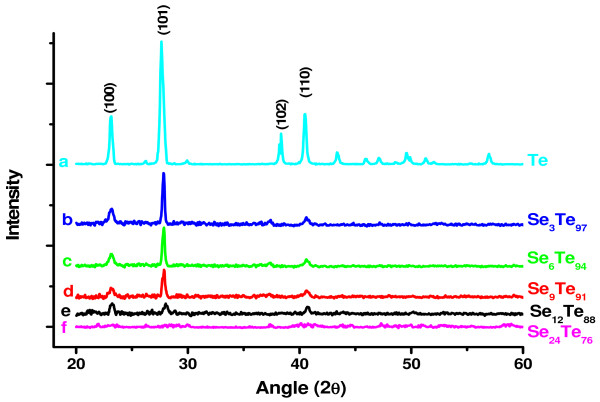
XRD pattern of the as-synthesized thin film of SexTe100 −xnanoparticles.